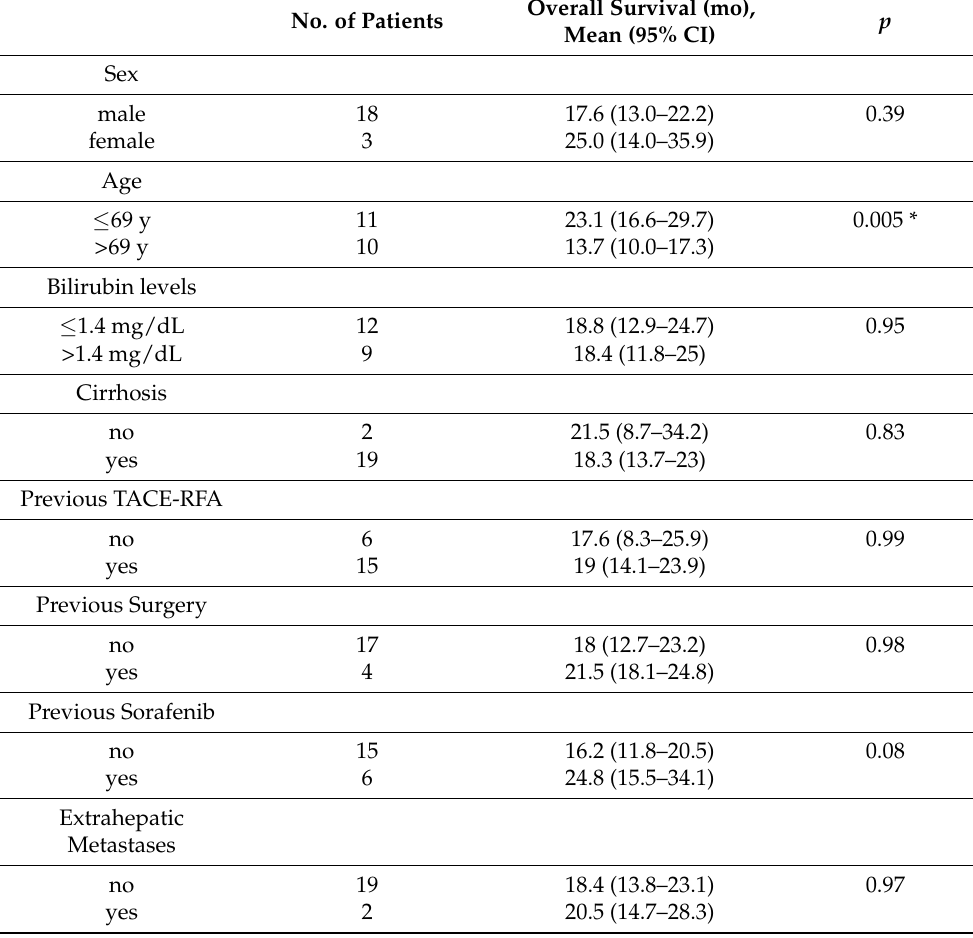
Table 4. Results of Kaplan–Meier analysis of variable potentially predicting